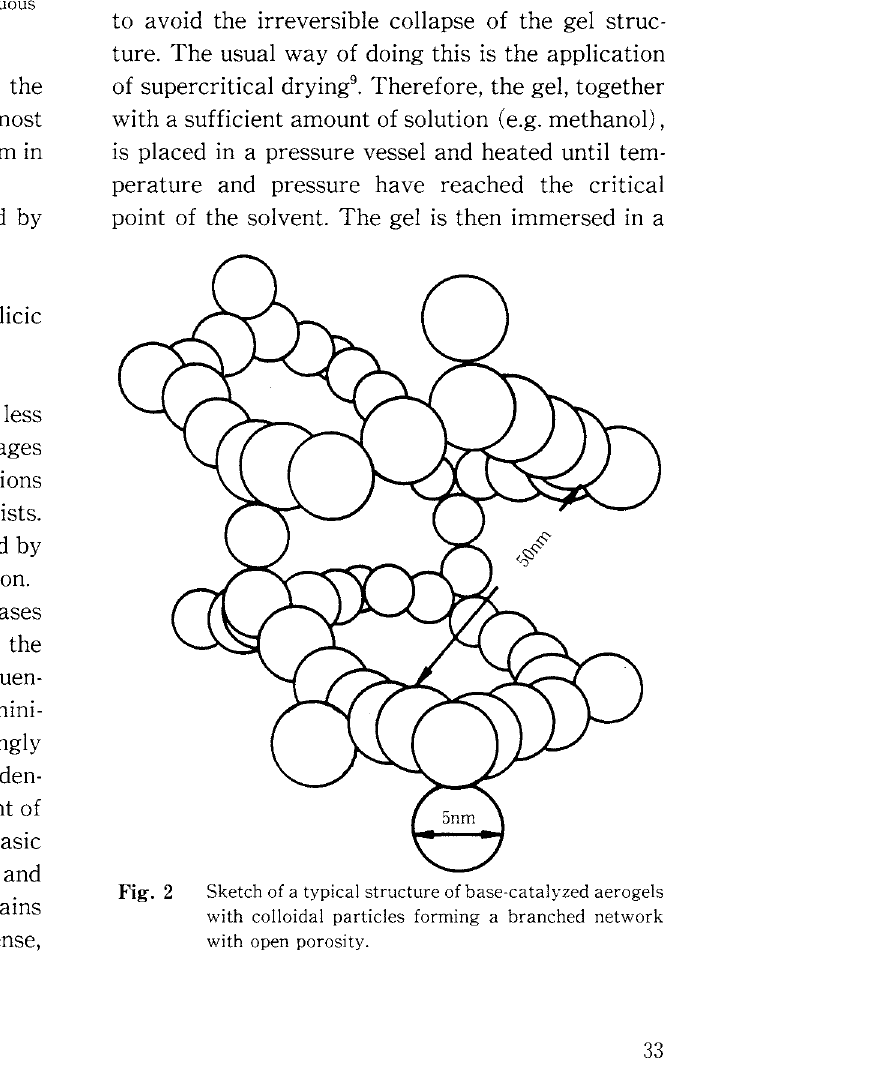
Upon normal drying, the wet gel experiences strong capillary forces that cause a collapse of the tenuous network.